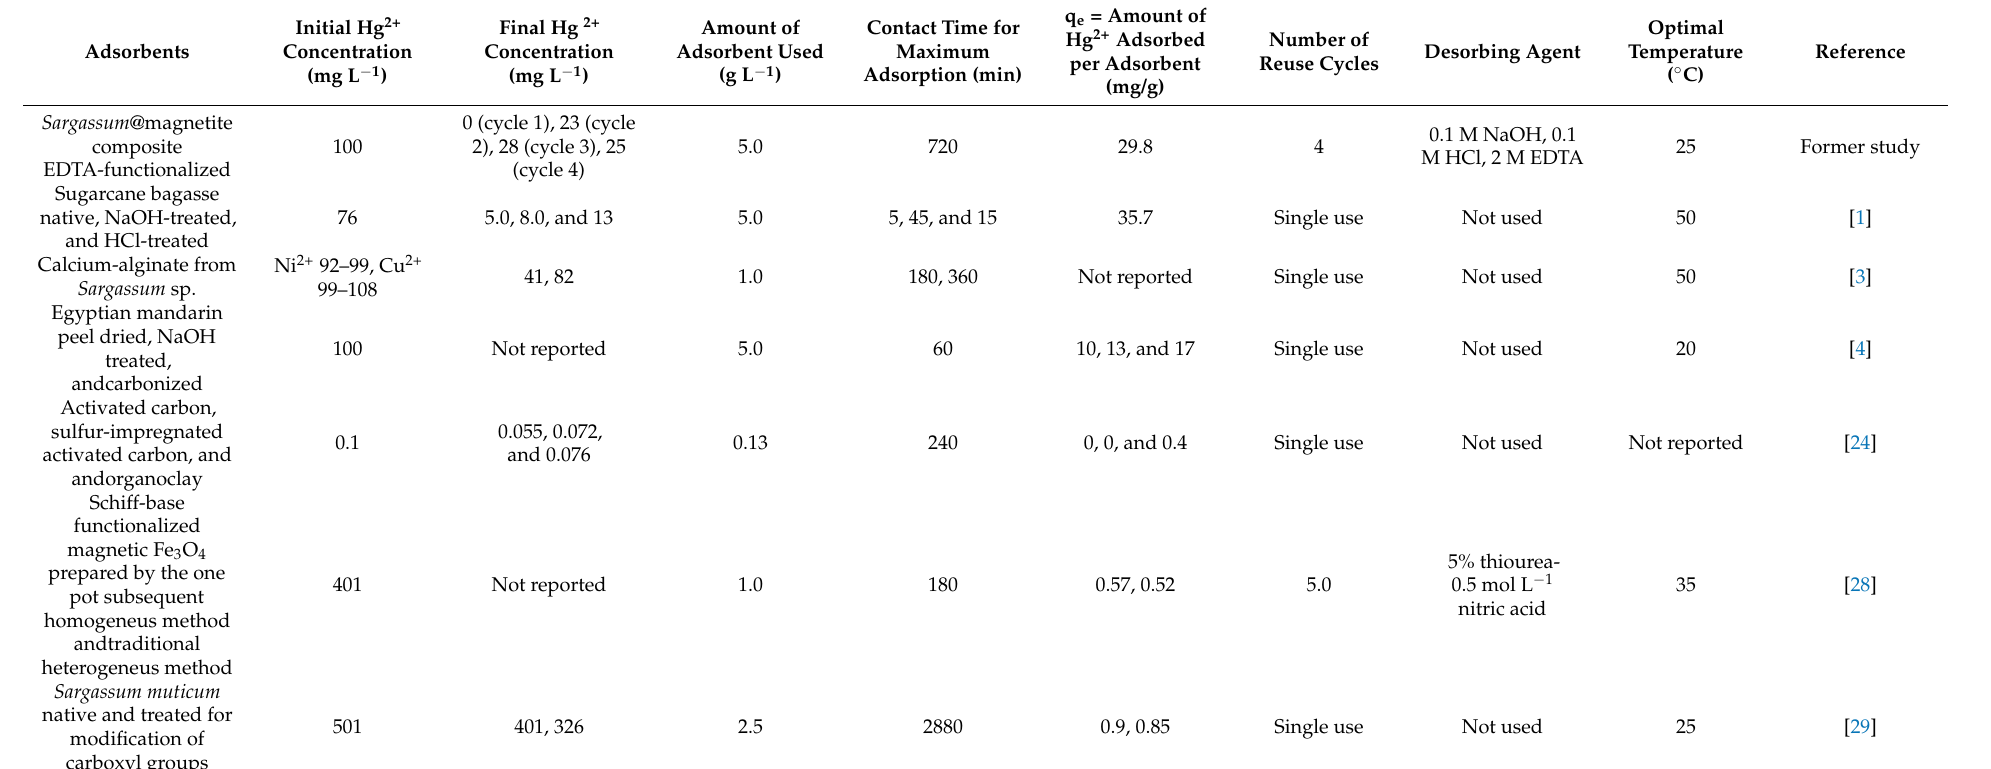
Table 3. Comparison of Hg 2+ removal using different adsorbent